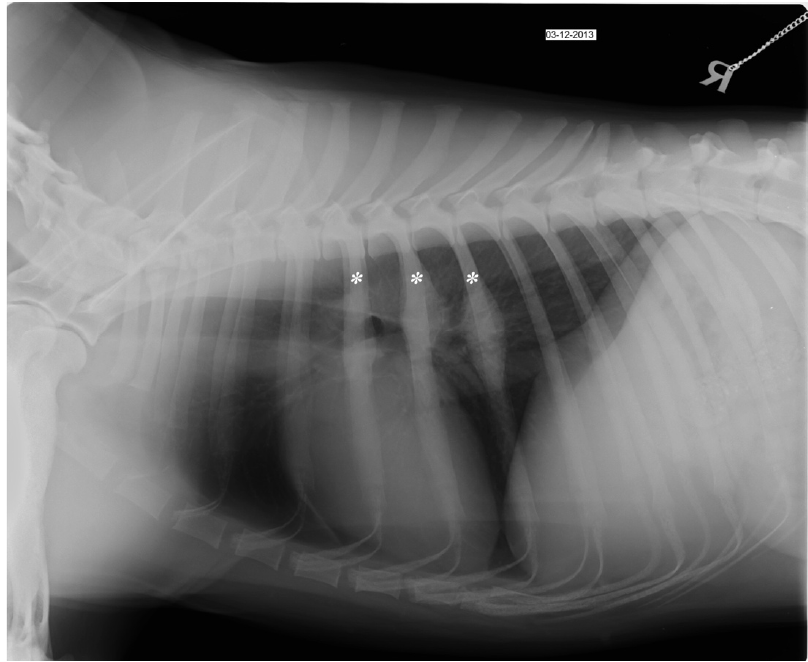
Figure 2. Right lateral (LL) thoracic radiograph at the day of first admission shows focal periosteal reaction of the 5th, 6th and 7th ribs (asterisk).